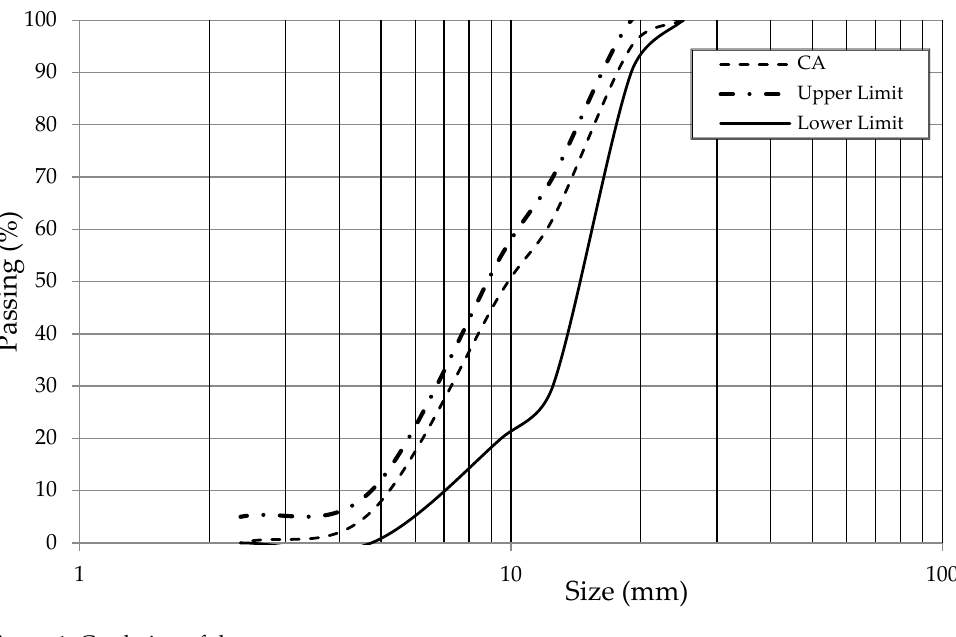
Figure 1. Gradation of the coarse aggregate.